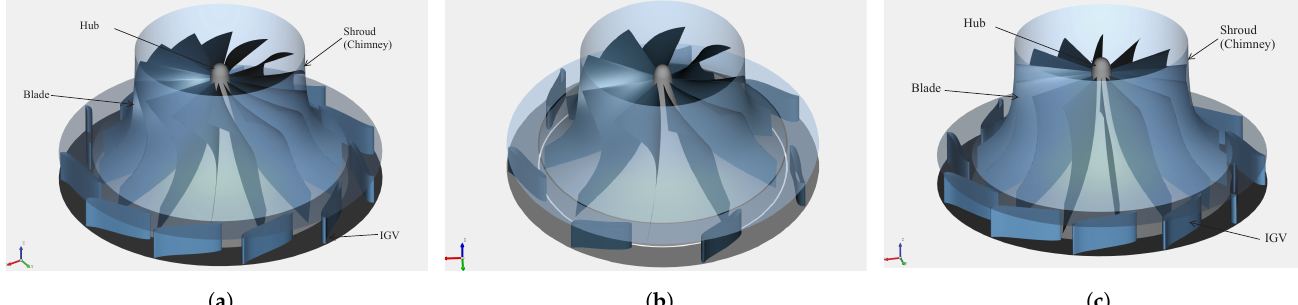
Figure 7. 3D model of the stator and rotor completed in CFturbo for the three designs. Direction of rotation— counterclockwise. ( a ) First design; ( b ) second design; ( c ) third